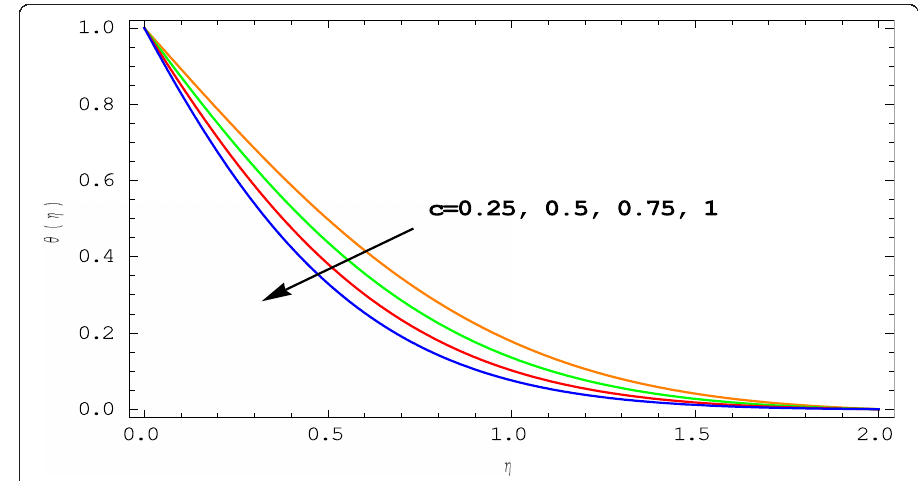
Fig. 12 Fluid temperature with increasing of the suction parameter ( c )